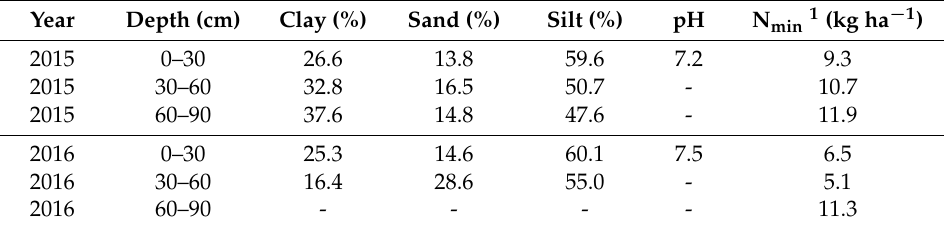
Table 2. Physical and chemical soil characteristics of the experimental field in 2015 and